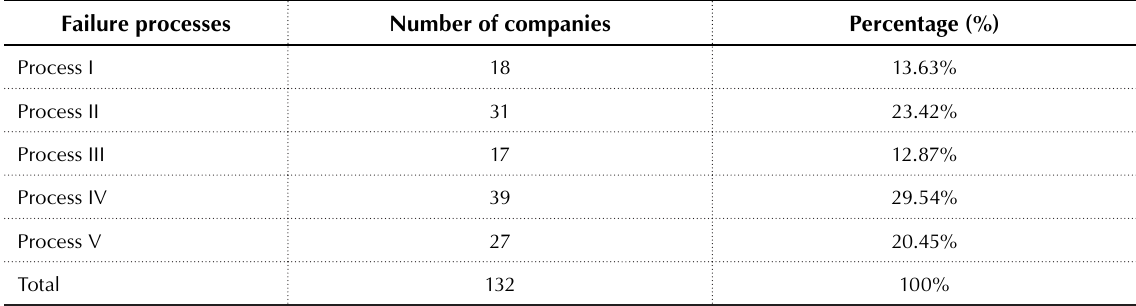
Table 7. Groups of companies that follow different failure processes